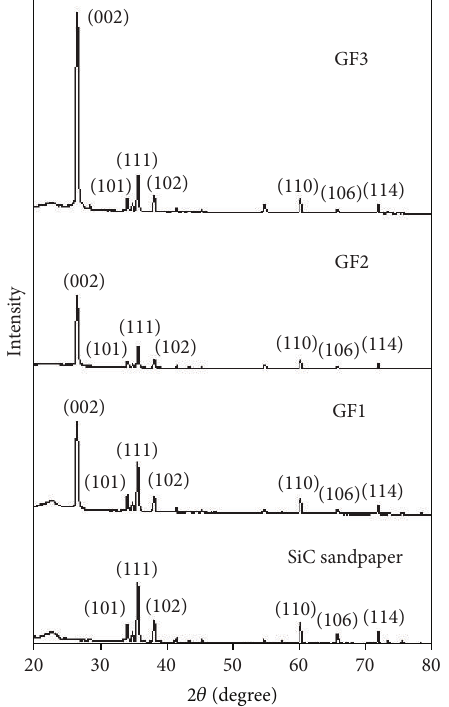
Figure 2: XRD patterns of graphite layers as a function of the amount of the graphite assembled on SiC sandpaper as substrate.